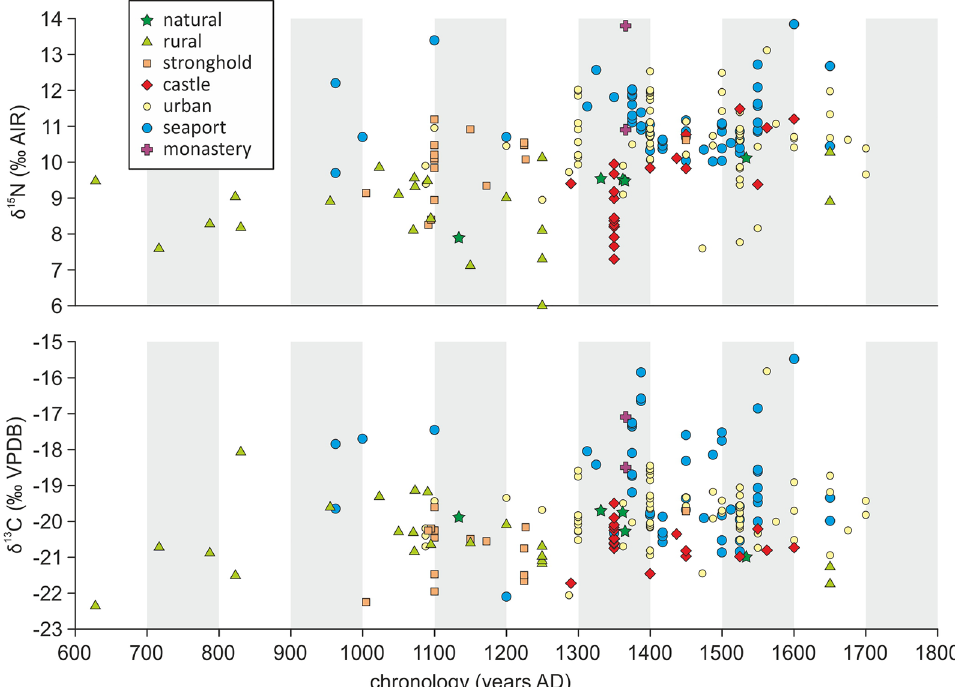
Figure 2. δ 13 C and δ 15 N values vs. specimen chronology in the cats analyzed in this study. The chronology reported for each specimen is the central point (± 1-year accuracy) of the site chronology range or the central point of the 95.4% probability range of the radiocarbon date. For full chronology ranges see Datasets S1 and S2 and for each socio-economic context shown separately see SI Appendix, Figs. S1 and